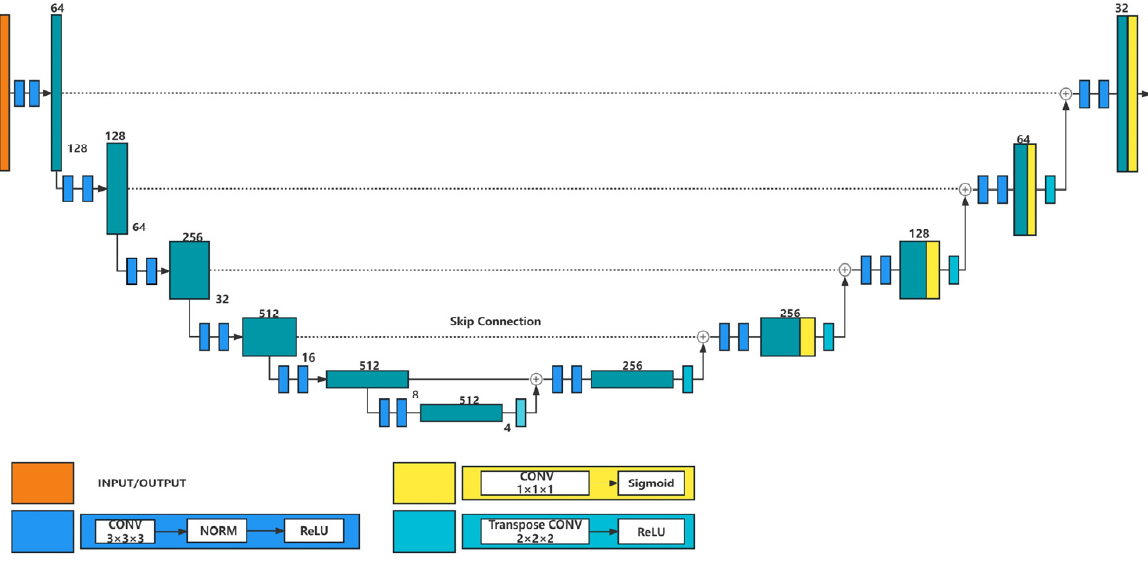
Figure 2. Segmentation model architecture.